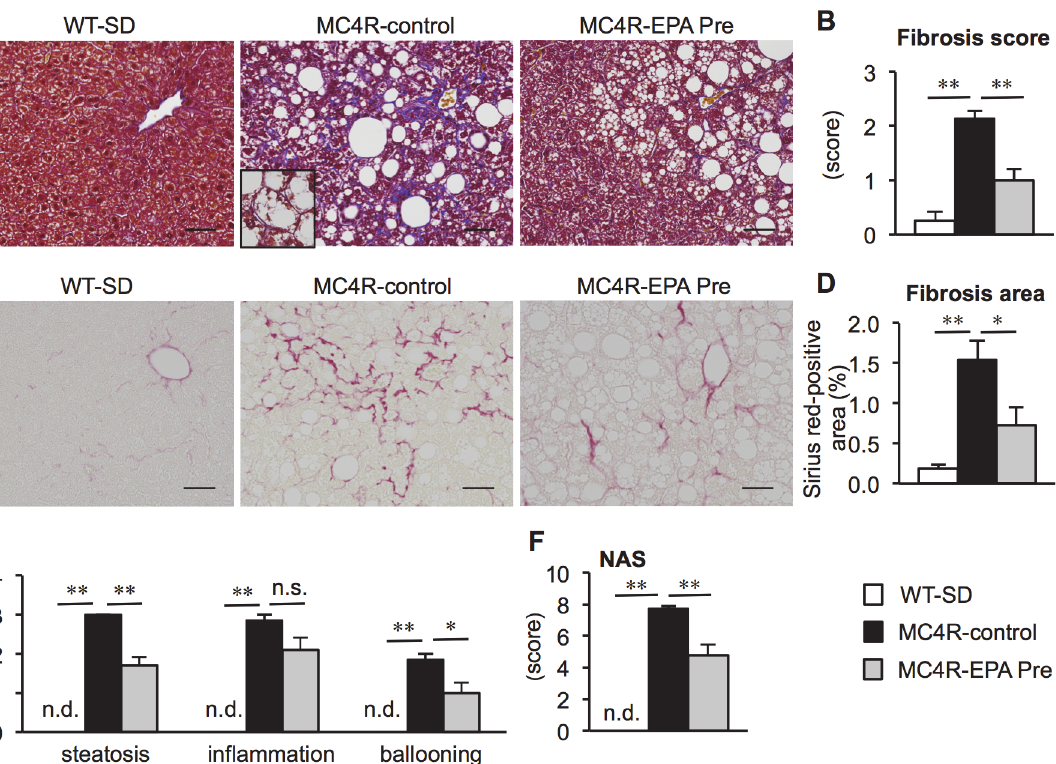
Fig 2. Effect of EPA on liver injury and fibrosis in MC4R-KO mice. Fibrillar collagen deposition evaluated by Masson-trichrome staining (A) and fibrosis scores (B) at 24 weeks. Inset: Representative image of hepatocyte ballooning. Sirius red staining (C) and quantification of Sirius red-positive area (D). Scores of steatosis, lobular inflammation, ballooning degeneration (E) and non-alcoholic fatty liver disease activity score (NAS) (F). Scale bars, 50 μ m. * P < 0.05; ** P < 0.01; n.s., not significant; n.d., not detected. WT-SD, n = 8; MC4R-control, n = 7; MC4R-EPA Pre, n = 10.